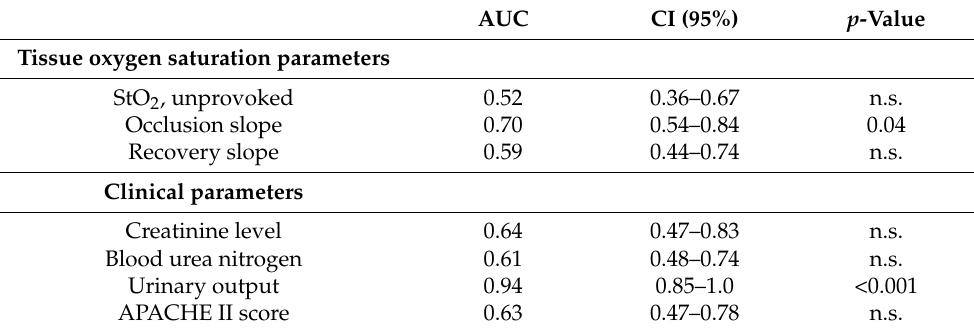
Table 2. Unprovoked StO 2 , VOT parameters, APACHE II score, and creatinine level at baseline and their respective AUC values, regarding the prediction of renal replacement therapy.